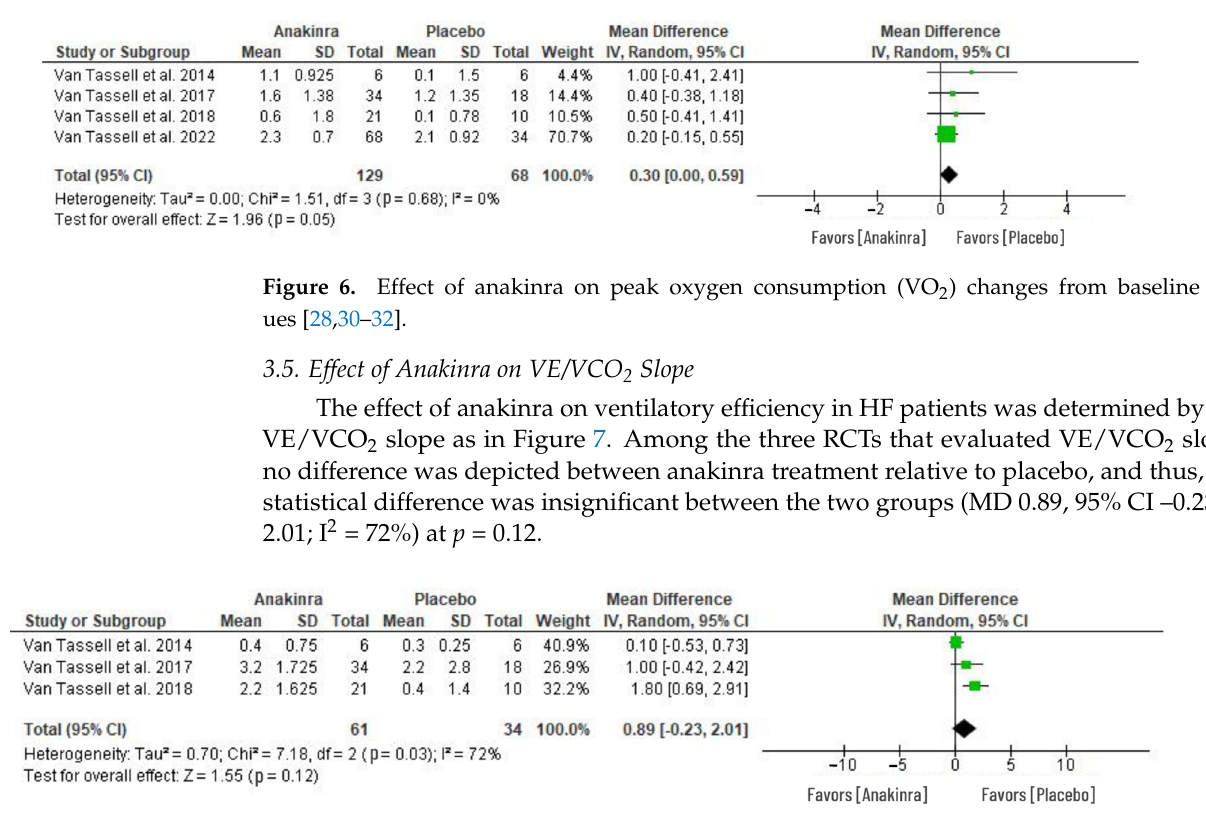
Figure 7. Effect of anakinra on ventilatory efficiency [28,30,31].